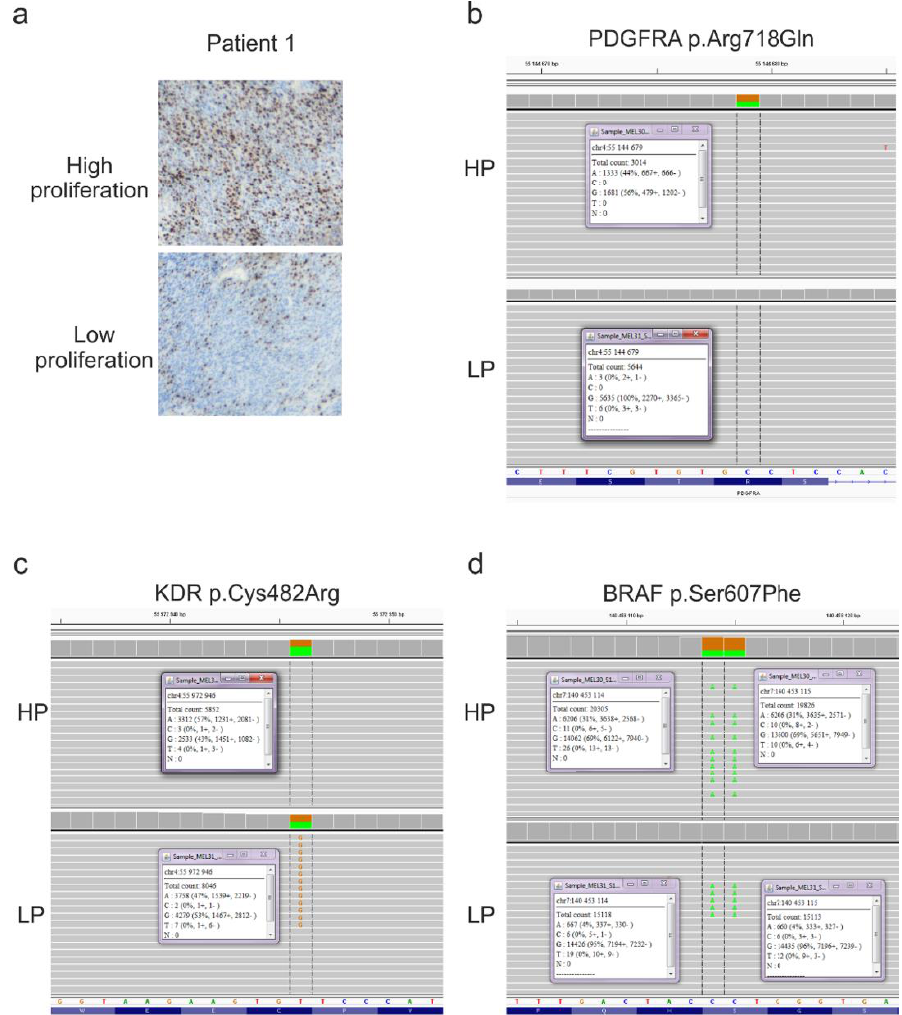
Figure 5. Representative molecular characteristics of patient 1. ( a ) Representative microphotographs of Ki-67 staining of chosen compartments of high proliferation (HP) and low proliferation (LP) of melanoma tissue. Magnification 20 × . ( b ) p.Arg718Gln mutation in PDGRFA gene as a representative variant detected only in HP compartment. ( c ) p.Cys482Arg mutation in KDR gene as a representative variant detected in similar variant allele frequency (VAF) in both compartments. ( d ) p.Ser607Phe variant in BRAF gene as a representative variant detected in both compartments but with substantially higher VAF in HP (31%) than LP (4%) compartment.